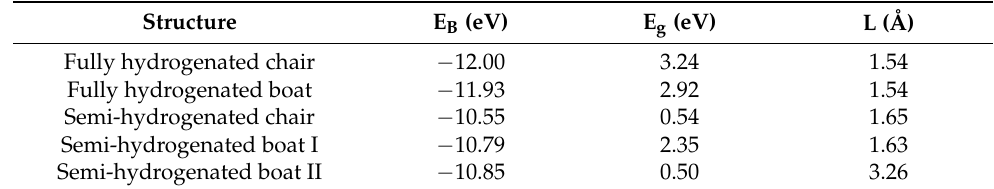
Table 1. Estimated binding energy per carbon atom (E B ), bandgap (E g ) and interlayer bond length (L) for chair and boat conformations of fully hydrogenated and semi-hydrogenated graphene, respectively [23]. Labels I and II refer to boat conformations with and without interlayer bonding, respectively.